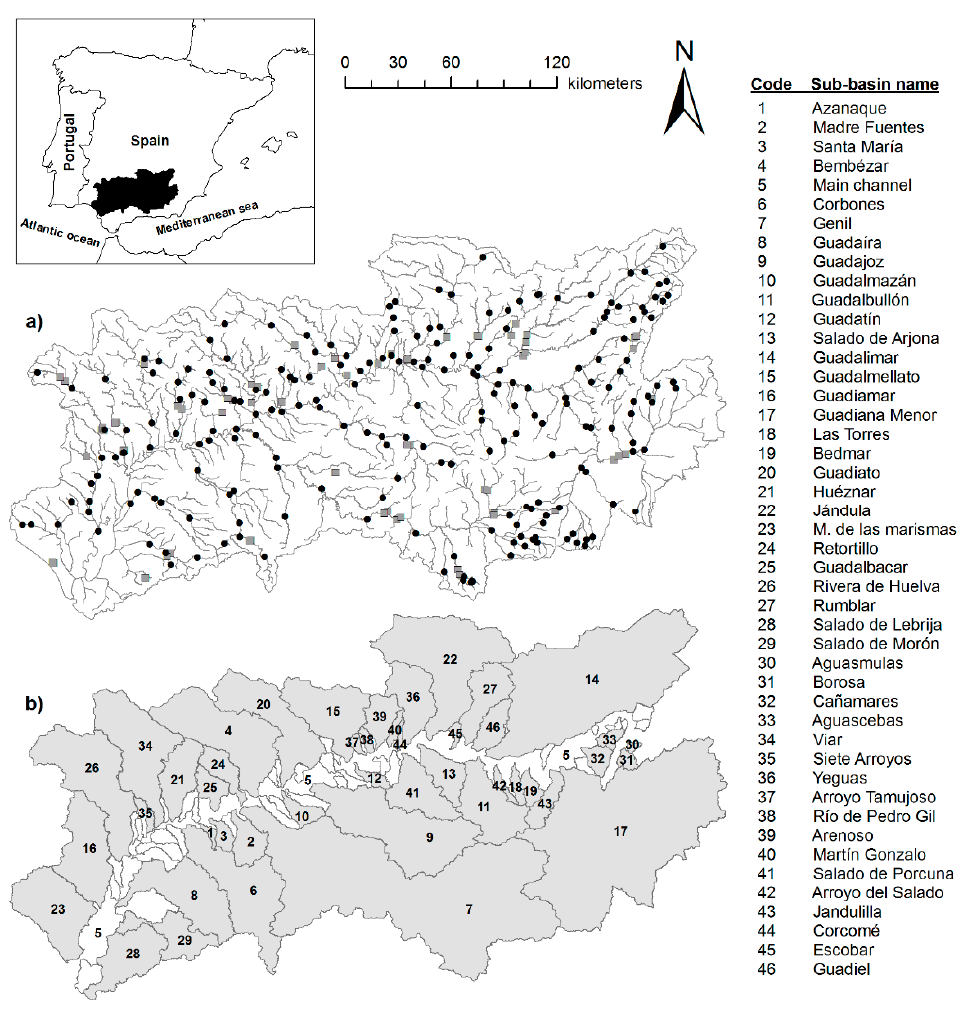
Figure 1. Map of the Guadalquivir River Basin. ( a ) Fish sampling sites: filled circles indicate rivers (n = 216) and grey squares denote reservoirs (n = 69). ( b ) Map of sub-basins sampled (gray color) and main channel (code-number 5) in the Guadalquivir River Basin. The code-number indicates the name for each